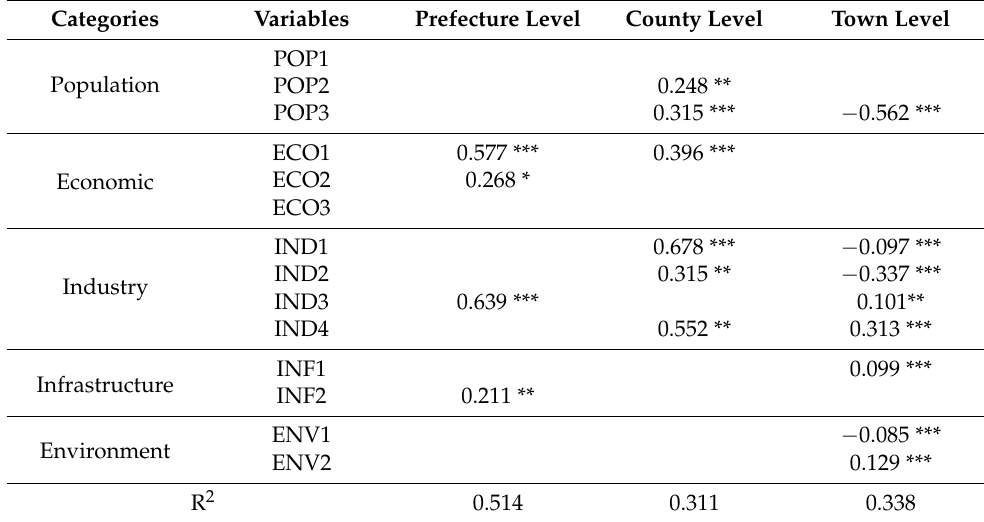
Table 3. Factors influencing city and town shrinkage in Northeast